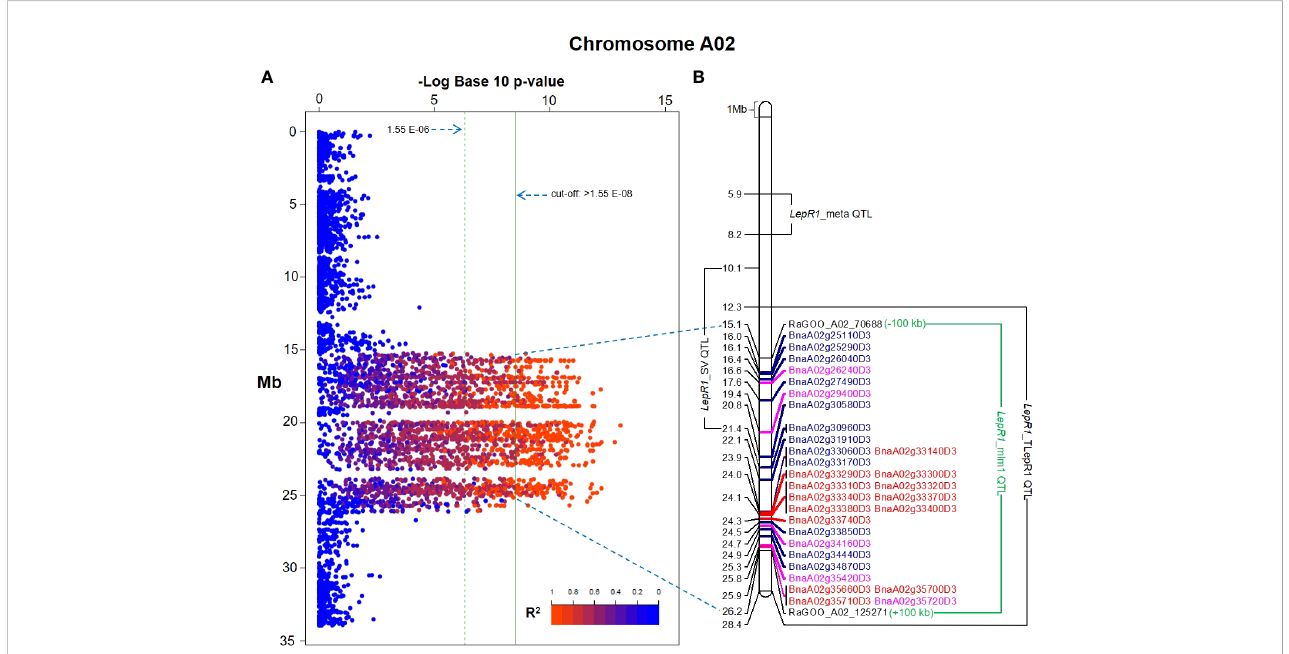
FIGURE 2 Mixed linear model (MLM)- genome-wide association study (GWAS) Manhattan plot in chromosome A02 of Brassica napus cv. Darmor bzh v9 showing SNPs and their linkage disequilibrium estimates in R 2 (A) . Physical map of the fl anking signi fi cant SNPs, RaGOO_A02_70688 and _125271, delineating the current quantitative trait loci (QTL) along its resistance gene analogs (RGAs) (red font=nucleotide binding site leucine rich repeats, blue font=receptor- like protein kinase, pink font=transmembrane-coiled coil) and previous QTL associated to LepR1 blackleg resistance in Brassica napus (B)